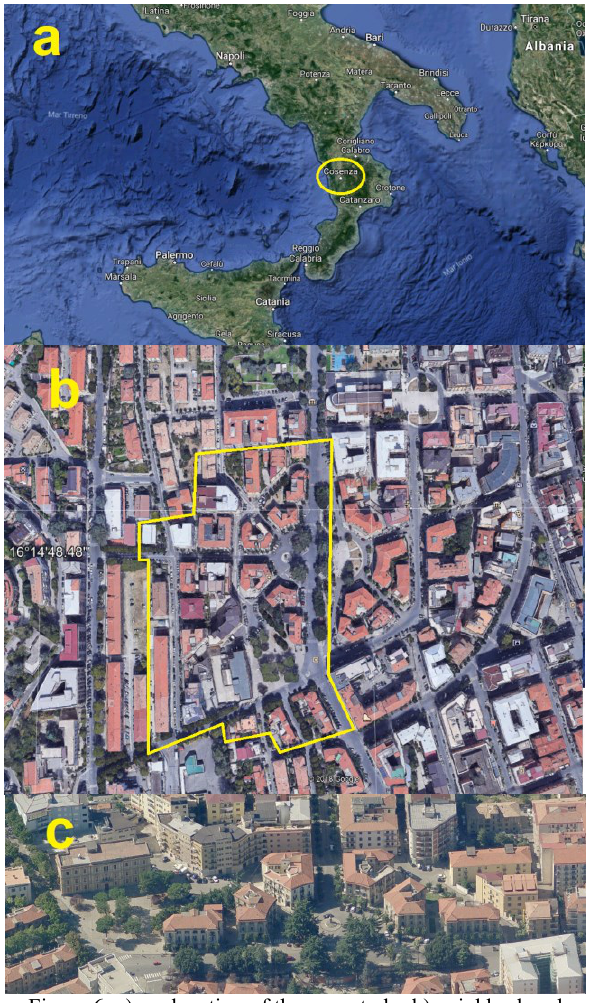
Figure 6. a) geolocation of the case study; b) neighborhood orthophoto; c) aerial view.